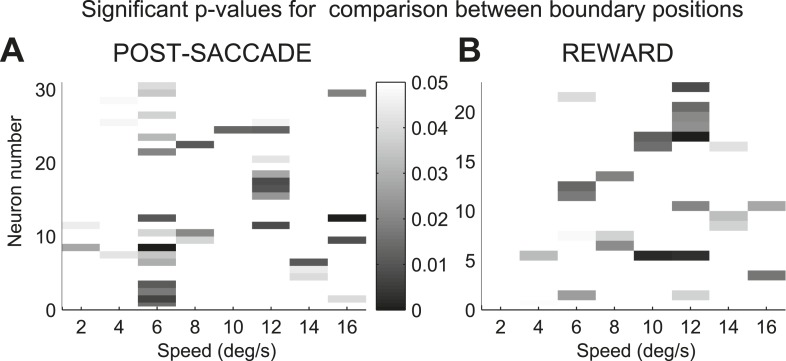
Sensitivity to the boundary position in caudate neurons.(A and B) Distribution of significant p-values indicating difference in spike count between slow and fast boundary positions for neurons with activity during the post-saccade (A) and reward (B) periods of the task. Only values of less than 0.05 are shown.